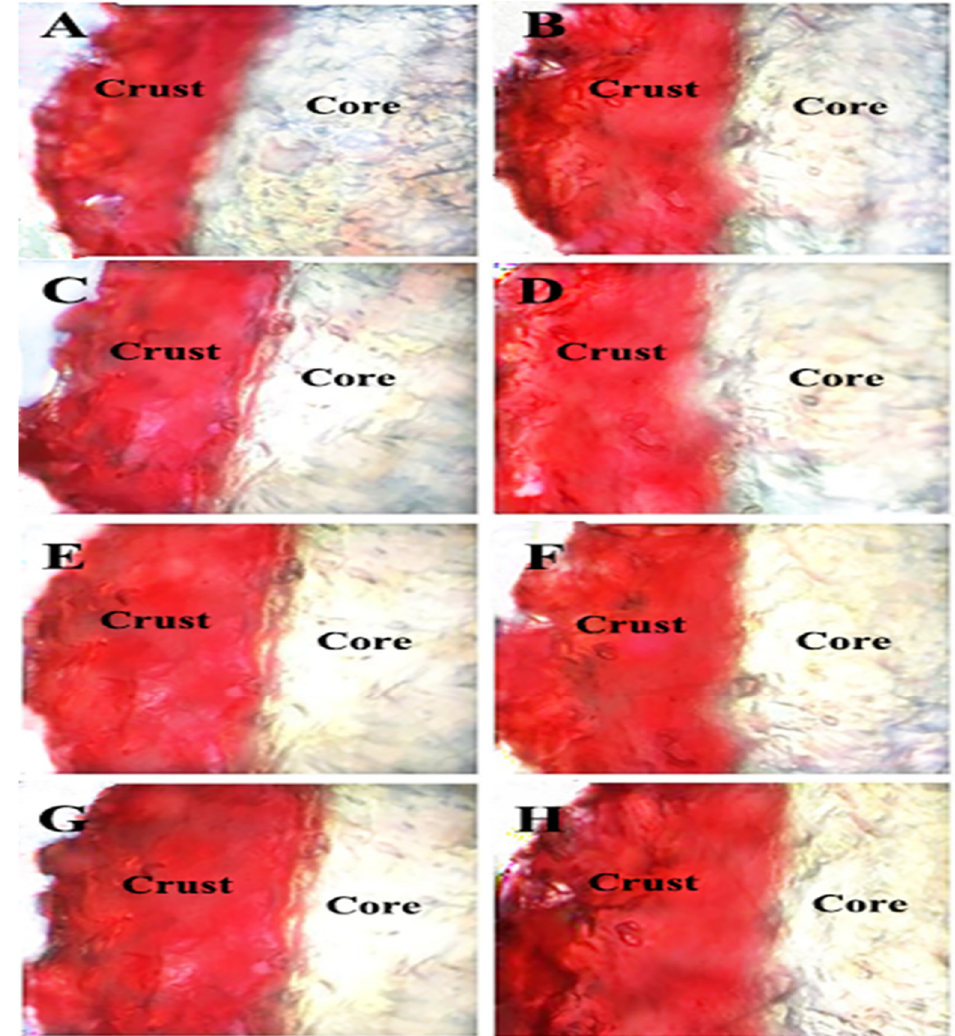
Figure 3. Optical microscopic images of fried BBFNs using Sudan Red B-containing oils. All of the images were taken at 4 × magnification in reflective mode. ( A ) Fresh rapeseed oil; ( B ) preheated rapeseed oil; ( C ) fresh soybean oil; ( D ) preheated soybean oil; ( E ) fresh rice bran oil; ( F ) preheated rice bran oil; ( G ) fresh palm oil; and ( H ) preheated palm oil.